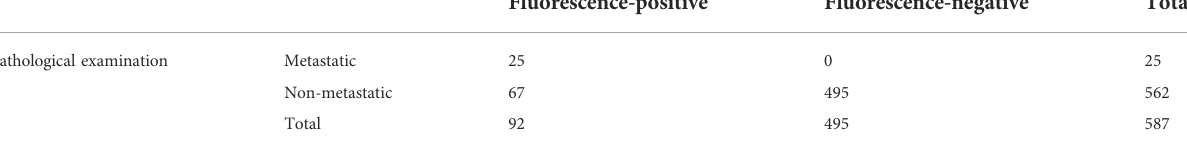
TABLE 4 Diagnostic statistics for intraoperative NIR fl uorescence